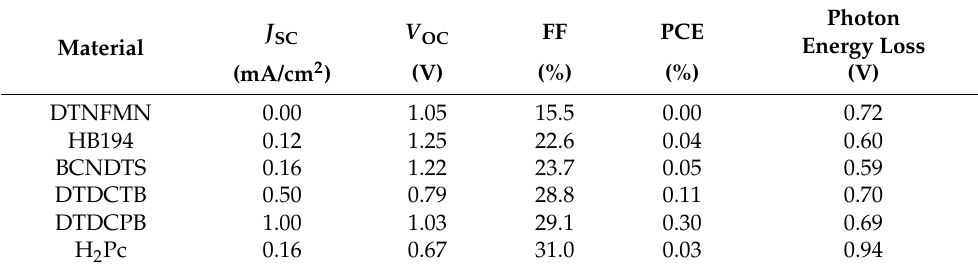
Table 1. Device performance parameters of the single-component photovoltaic devices.